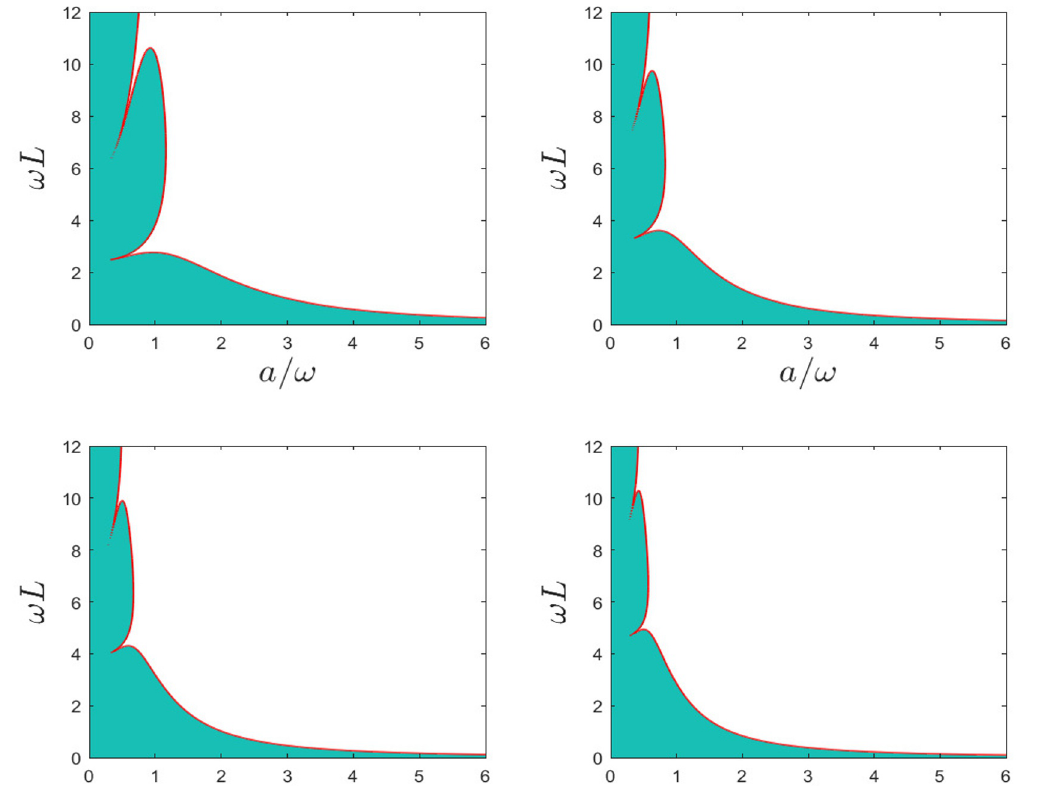
Figure 3 . Entanglement region in the a − L plane. The four subfigures stand for D = 3 , D = 4 , D = 5 , D = 6 respectively from left to right and top to